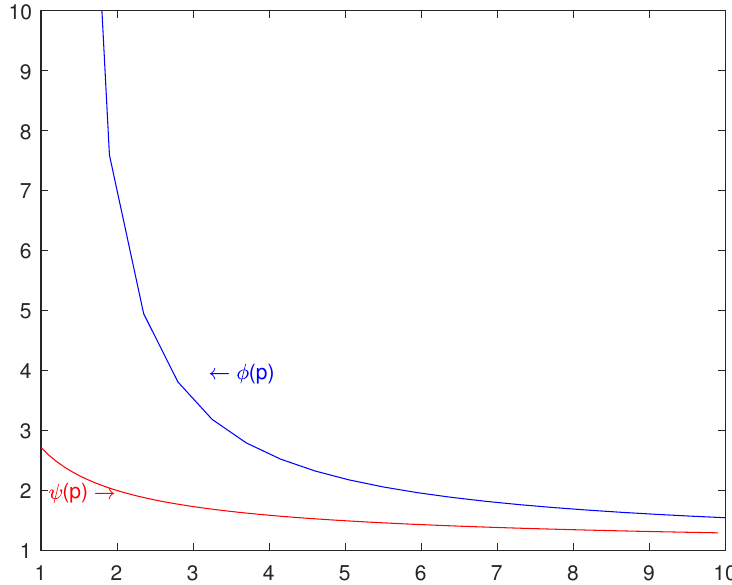
Figure 1. Computer confirmation of φ ( p ) and ψ ( p )